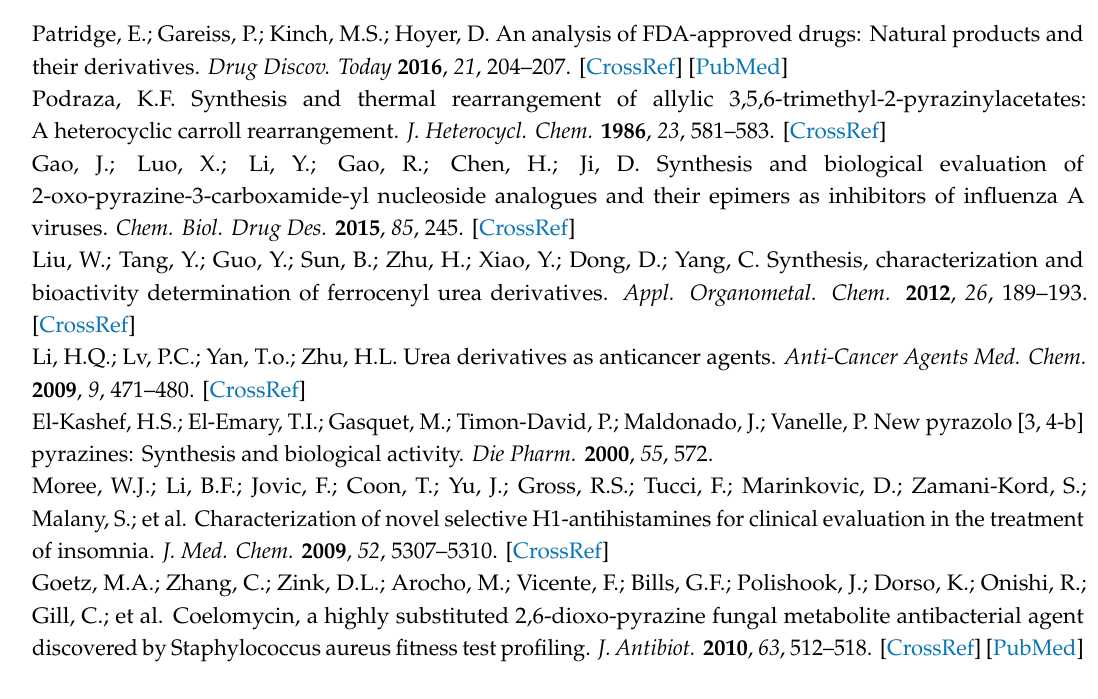
Figure S2: RB2-FT-IR, LC-MS and 1 H-NMR, Figure S3: RB3-FT-IR, LC-MS and 1 H-NMR, Figure S4: RB4- FT-IR, LC-MS and 1 H-NMR, Figure S5: RB5-FT-IR, LC-MS and 1 H-NMR, Figure S6: RB6 FT-IR, LC-MS and 1 H-NMR, Figure S7: RB7 -FT-IR, LC-MS and 1 H-NMR, Figure S8: RB8 -FT-IR, LC-MS and 1 H-NMR, Figure S9: RB9-FT-IR, LC-MS and 1